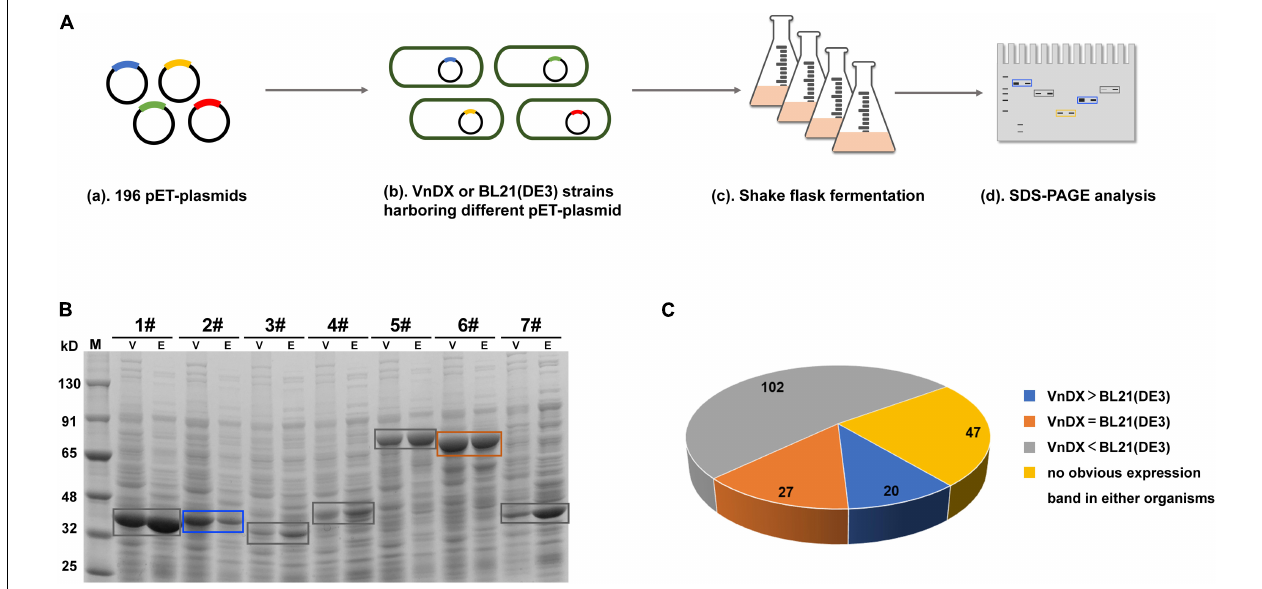
FIGURE 1 | Evaluation of the soluble expression of 196 genes of interest (GOIs) in Escherichia coli and Vibrio natriegens . (A) Flowchart about shake-flask fermentation of 196 GOIs and soluble expression comparison between E. coli BL21(DE3) and V. natriegens VnDX. (B) Compare the soluble expression of the same GOI in E. coli and V. natriegens through sodium dodecyl sulfate polyacrylamide gel electrophoresis (SDS-PAGE). Here, 0.15 OD 600 (10-well gel) or 0.075 OD 600 (15-well gel) prepared crude protein samples were loaded to the corresponding protein gel wells. V, V. natriegens VnDX; E, E. coli BL21(DE3); Blue box, GOI possessing higher expression in VnDX than BL21(DE3); Orange box, GOI possessing the same expression in VnDX and BL21(DE3); Gray box, GOI possessing higher expression in BL21(DE3) than VnDX. 1#: Alanine racemase from Bacillus subtilis 168; 2#: N-acetyl amino acid racemase from Alcaligenes sp.; 3#: N-acetyl amino acid racemase from Deinococcus radiodurans NCHU1003; 4#: N-acetyl amino acid racemase from Amycolatopsis sp. TS-1-60; 5#: Maltooligosaccharide trehalose synthetase from Arthrobacter sp. Q36; 6#: Maltooligosaccharide trehalose synthetase from Arthrobacterium S34; 7#: D-carbamoylase (K34E) from Burkholderia pickettii . (C) Pie chart about the soluble expression results of 196 GOIs. VnDX > BL21(DE3): GOI possessing higher expression in VnDX than BL21(DE3); VnDX = BL21(DE3): GOI possessing the same expression in VnDX and BL21(DE3); VnDX < BL21(DE3): GOI possessing higher expression in BL21(DE3) than